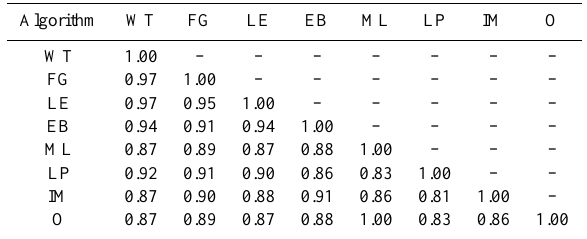
Table 1. Comparison of community detection algorithms with the normalized mutual information (NMI) index (Danon et al., 2005).